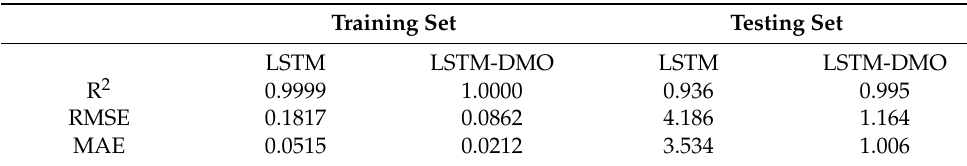
Table 1. Results of LSTM-DMO and LSTM